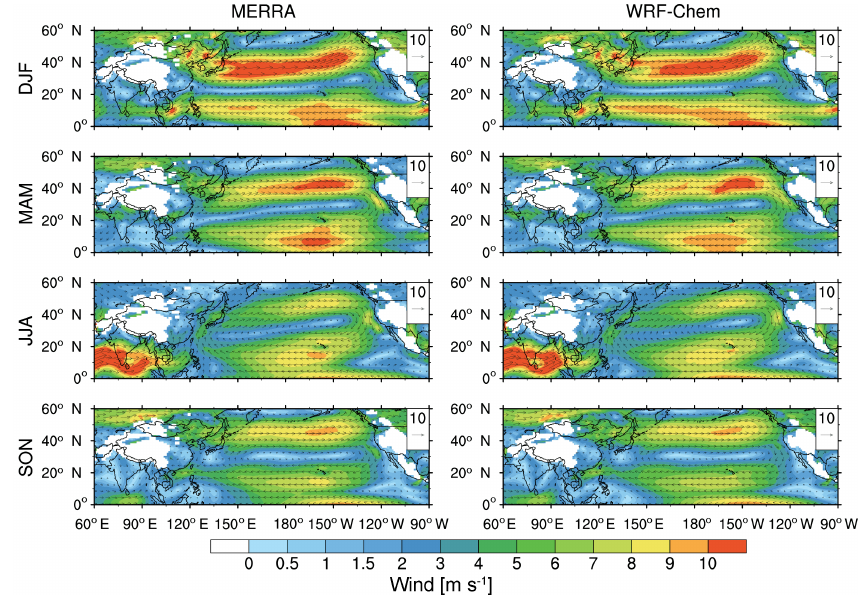
Figure 2. Spatial distributions of seasonal-averaged wind fields at 850hPa from the MERRA reanalysis and the WRF-Chem simulation for the period